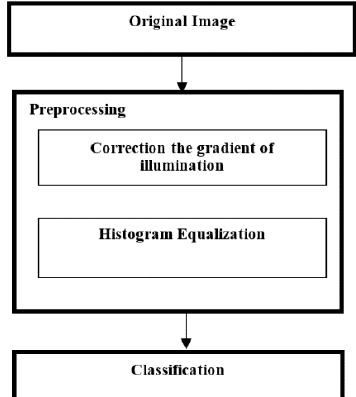
Fig. 1. Face Recognition System